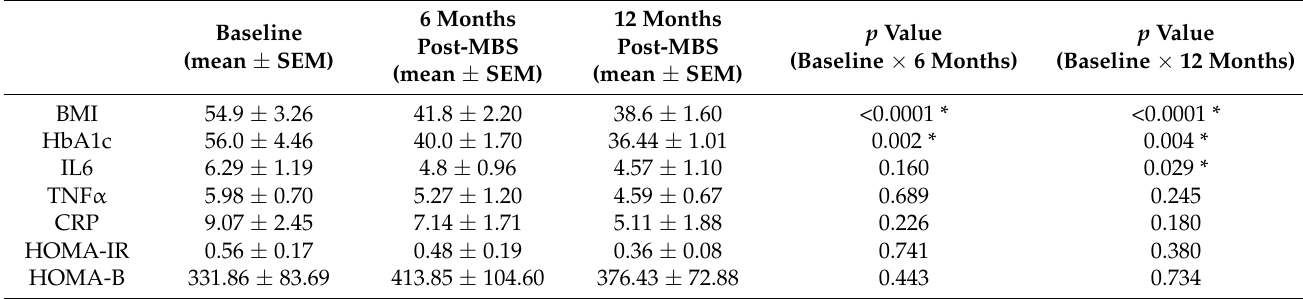
Table 1. Anthropometric and clinical results from ( n = 10) individuals having undergone metabolic bariatric surgery (MBS) at baseline and 6 and 12 months after MBS.